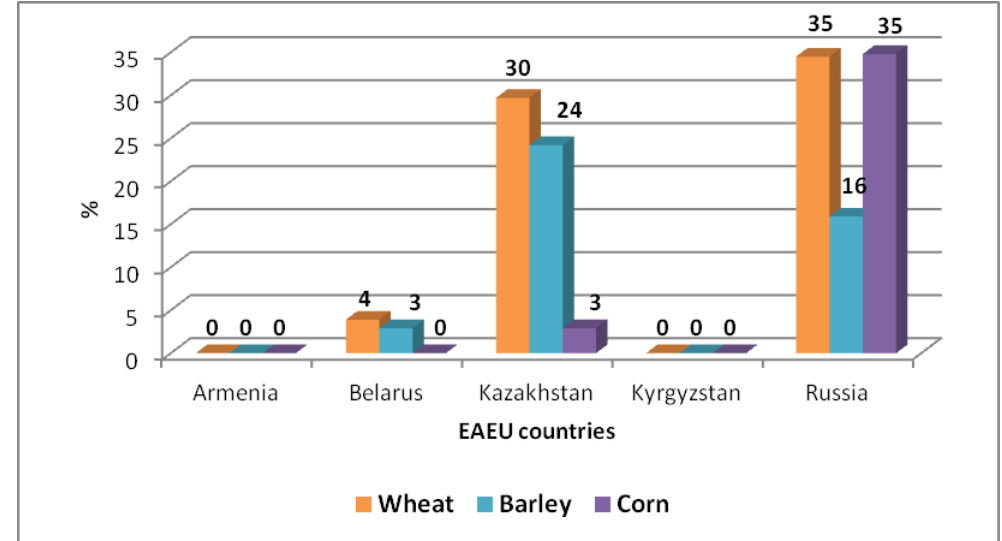
Figure 2. Share of exports in the volume of the production of wheat, barley, and corn in the EAEU countries, 2016, %. Source: compiled from UNComtrade and EEC data [20–25].